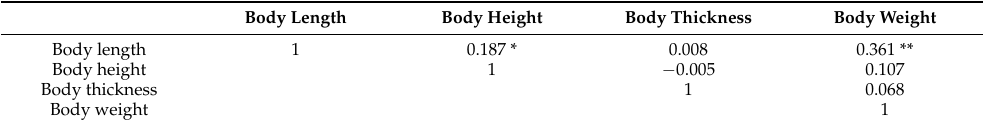
Table 1. Pearson correlations between the growth traits of Yellow River carp at 5–9 months after hatching. Body Length